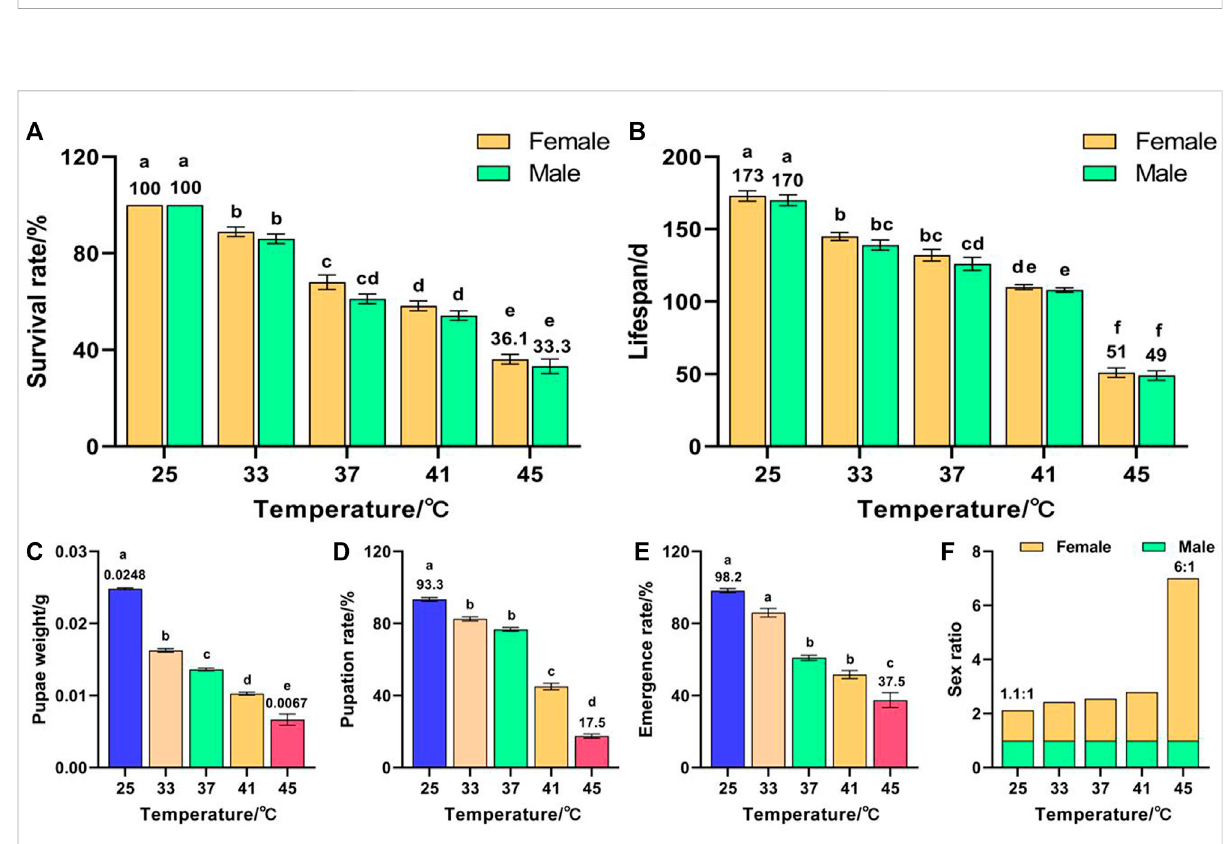
FIGURE 2 Effectsofshort-termhightemperatureonsurvivalandlifespanof Z.cucurbitae (F 2 ). (A) Survivalrate. (B) Lifespan. (C) Pupaeweight. (D) Pupation rate. (E) Emergence rate. (F) Sex ratio. The columns in the fi gure represent the mean ± standard error, and thelettersabove them indicate signi fi cant differences ( p ≤